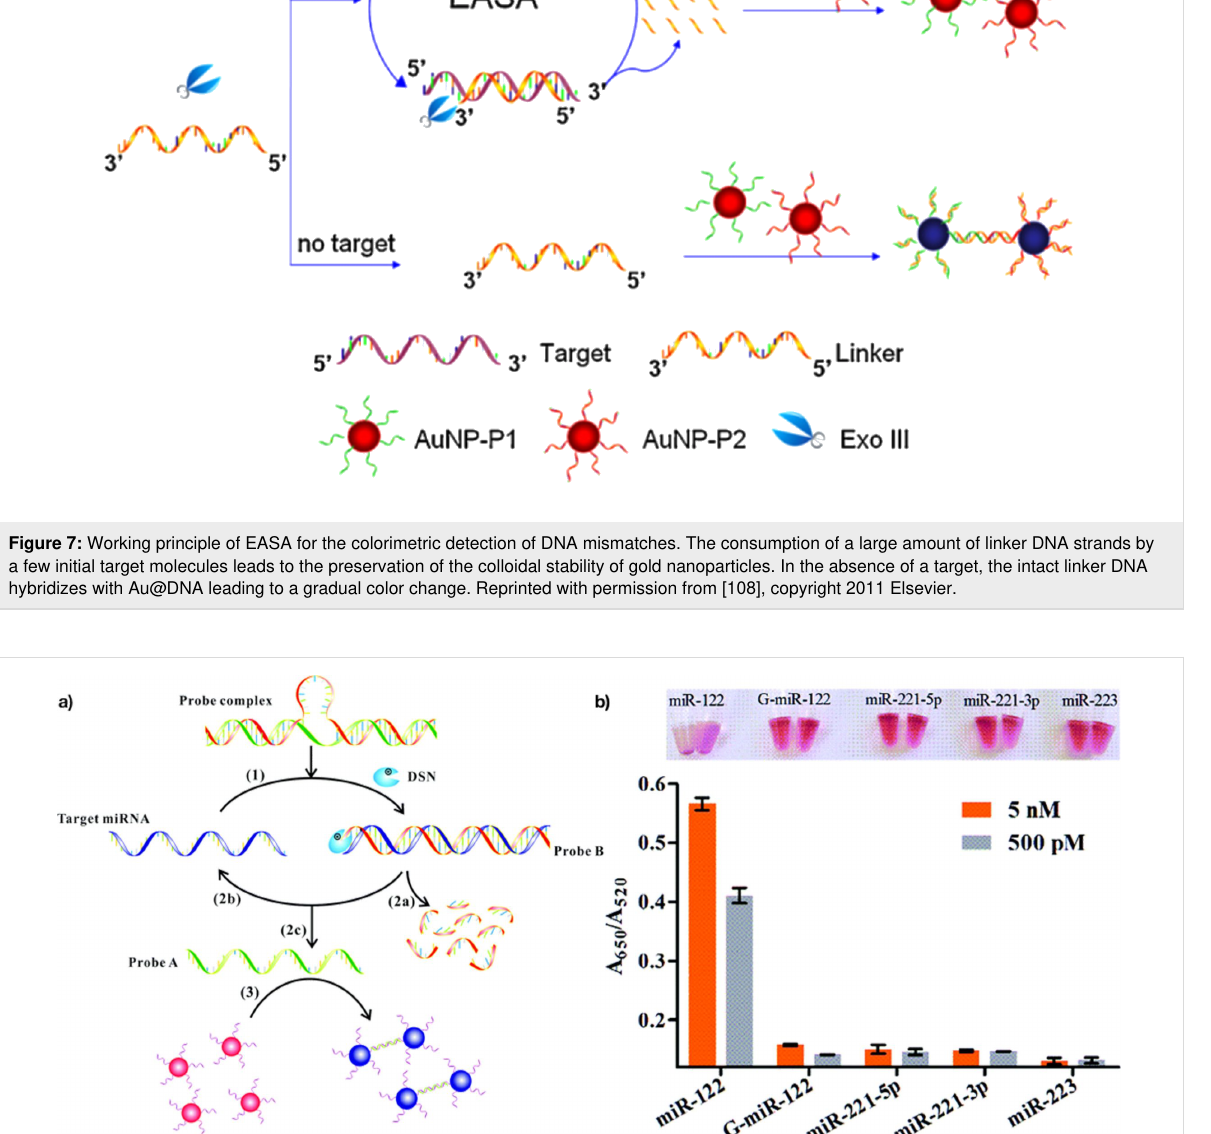
Another enzyme-assisted approach used in the discrimination of single-base mutations involves the combination of nicking endonuclease (NEase) and DNA polymerase giving rise to the so-called isothermal exponential amplification reaction (EXPAR). The EXPAR technique uses a DNA template, deoxynucleotide triphosphates (dNTPs) and two enzymes to achieve the exponential amplification of a target sequence.